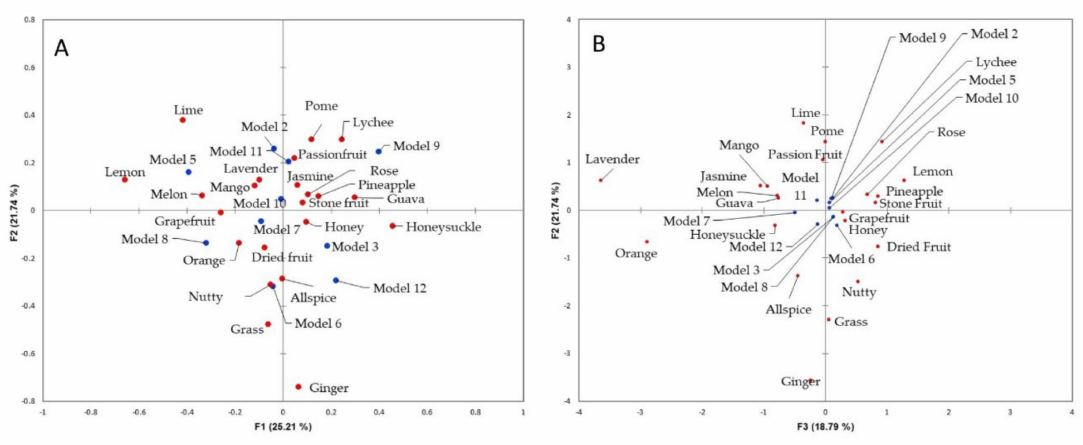
Figure 1. First three dimensions of results from corresponding analysis for CATA data, ( A ) F1 and F2, ( B ) F2 and